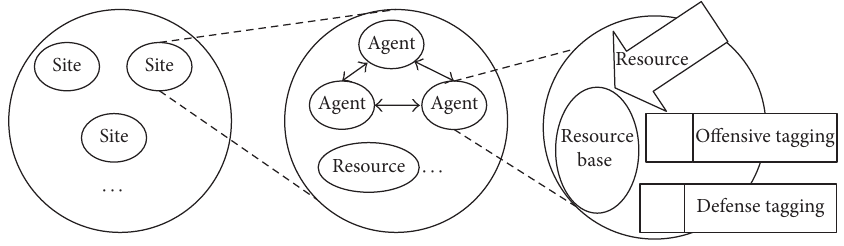
Figure 1: Schematic diagram of echo model. Source: Hu